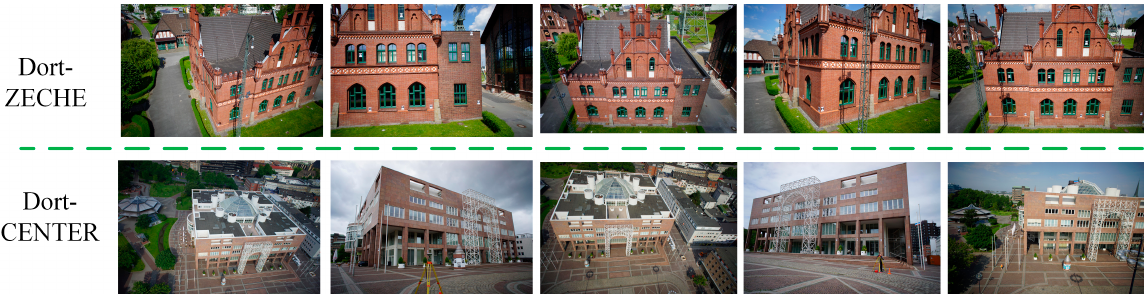
Figure 7. Partial images of the Dort-ZECHE and Dort-CENTER datasets.